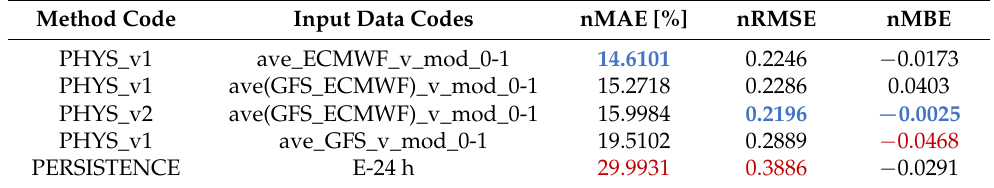
Table 6. Measures of performance of the proposed Physical Models (test subset) for Wind Farm